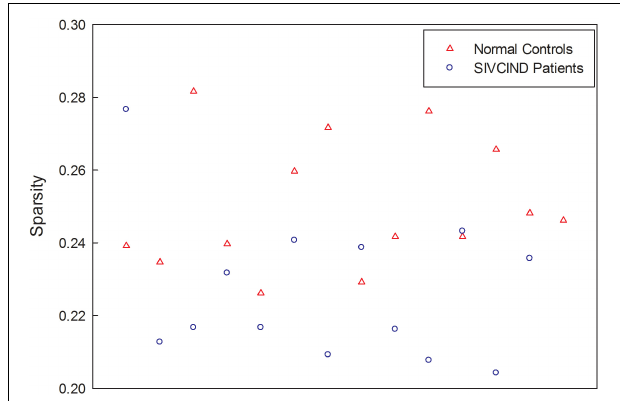
FIGURE 1 | The sparsity of each subject’s brain structural connectivity network.